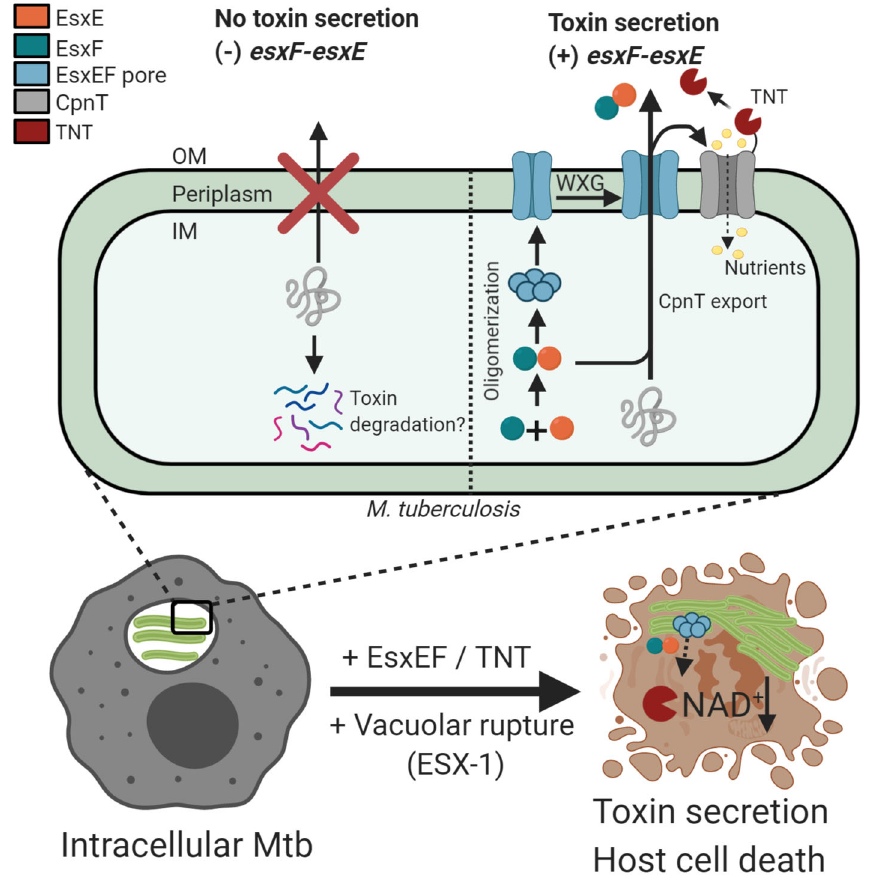
Fig. 7 Model of EsxE-EsxF mediated toxin secretion by Mtb. During intracellular infection of macrophages Mtb produces the outer membrane protein CpnT, which enables nutrient uptake and whose secreted C-terminal TNT domain is the major toxin of Mtb. TNT is only toxic when it gains access to the macrophage cytosol after rupture of the phagosomal membrane. EsxE-EsxF heterodimers form large, oligomeric complexes, which bind to membranes and form membrane-spanning pores, which extend to the cell surface. This process is required for export of CpnT to the cell surface of Mtb. EsxEF and CpnT/ TNT are then co-secreted and released into the macrophage cytosol leading to cell death. In the absence of EsxEF, CpnT is mislocalized and is possibly degraded in the cytosol of Mtb to prevent self-intoxication. This fi gure was created using